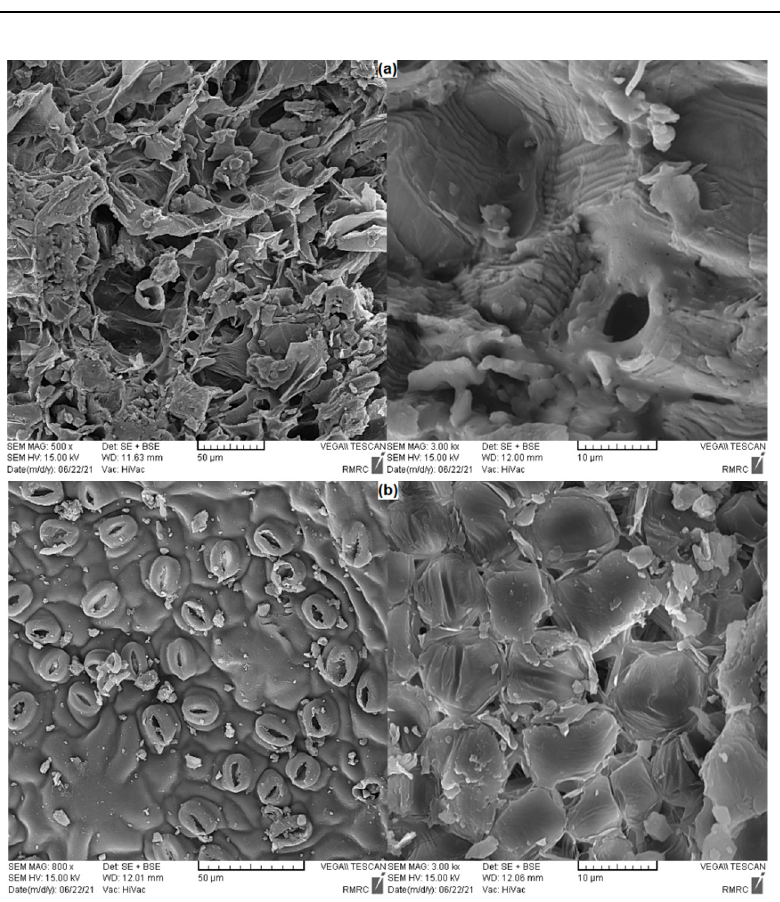
Figure 2. SEM images of ( a ) SC and ( b ) PG in a 50 µm and 10 µm scale. Table 2. Textural parameters of prepared